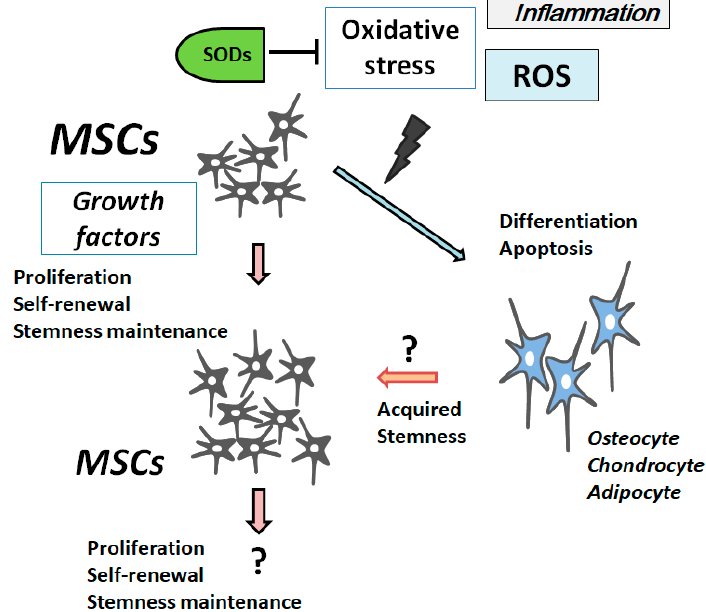
Figure 1. Illustration of mesenchymal stromal/stem cells (MSCs) proliferation and/or differentiation in response to the extracellular growth factor stimulation and/or oxidative stress. The model shows